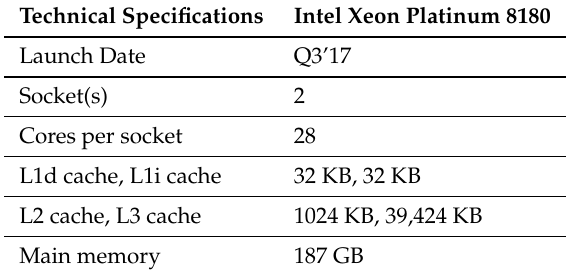
Table 3. HCLServer3: Specifications of the Intel Skylake multicore processor (CPU) consisting of two sockets of 28 cores